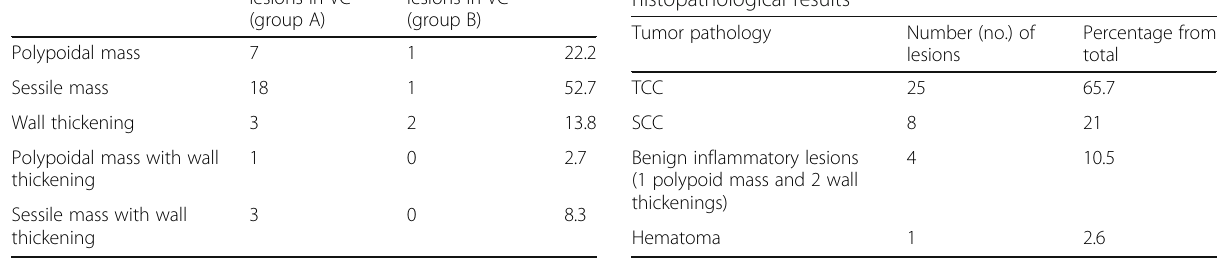
Anatomical distribution: (Table 10) Concerning the anatomical distributions of the lesions the sensitivity of VC in detection of bladder base lesions was 93%, while it was 100% in lesions at the dome, anterior wall, posterior wall, right lateral wall, left lateral wall, and intra-diverticular.